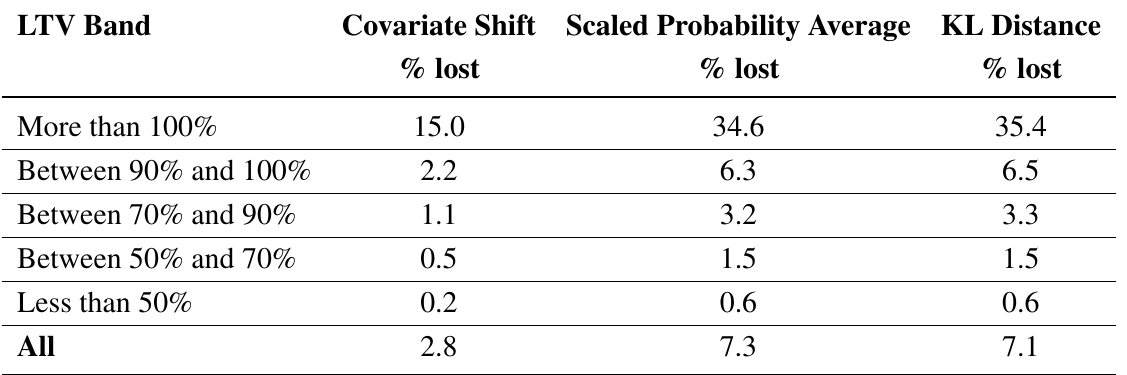
Table 2. This year’s loss rate forecast for portfolio from Table 1. The R 2 the Scaled Probability Average is